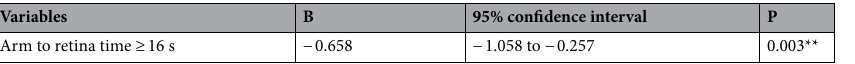
Table 2. Factors associated with visual outcome 12 months after initial treatment. Forced input analysis adjusted for age and initial best-corrected visual acuity. The selected factors were sex, initial central retinal